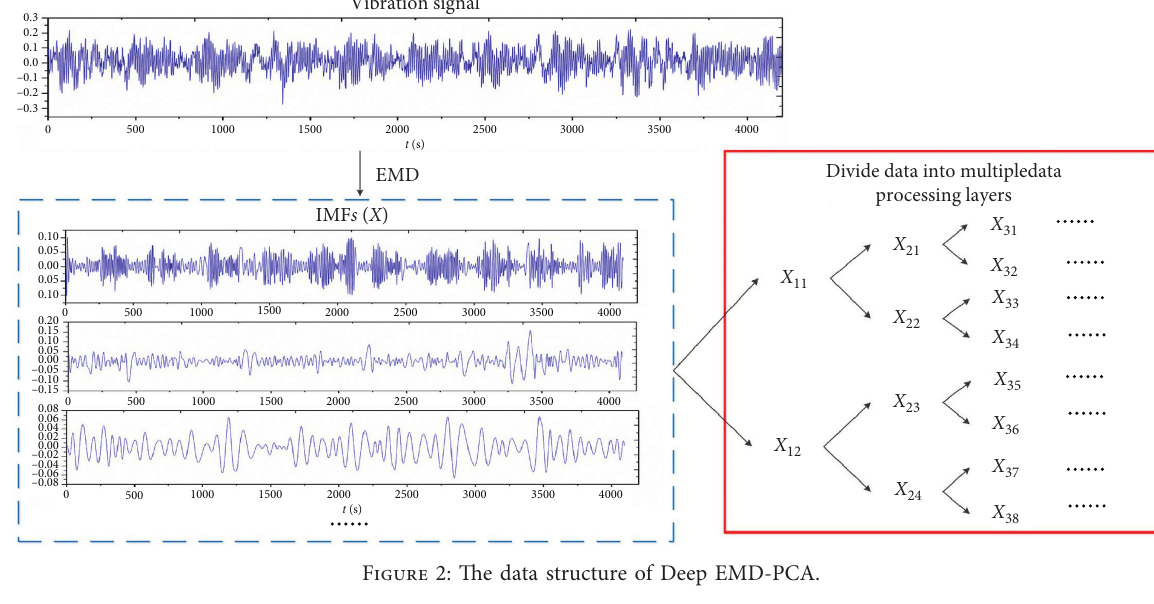
Figure 2: The data structure of Deep